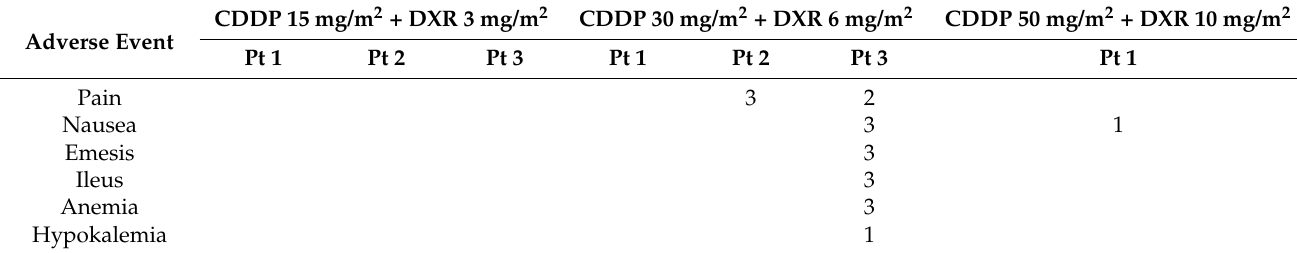
Table 2. Adverse events (CTCAE 4.03) according to dose level of Cisplatin and Doxorubicin. Adverse Event